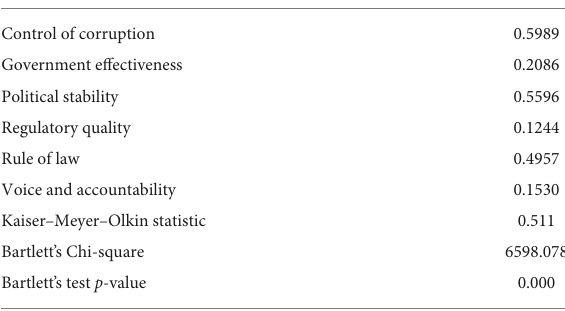
TABLE 6 Institutional Quality index.